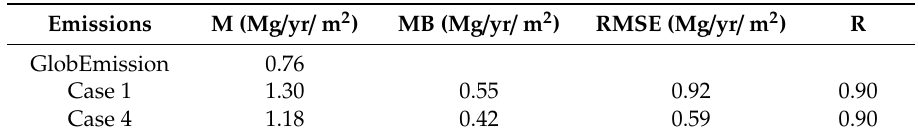
Figure 11. Correlation between modeling (bottom-up) and inverse (top-down) emissions in South Korea in June and July 2014: ( a ) Case 1; ( b ) Case 4. Table 11. Statistical performance measures (Mean, MB, RMSE, and R) between bottom-up emissions and GlobEmission for South Korea in June and July 2014.